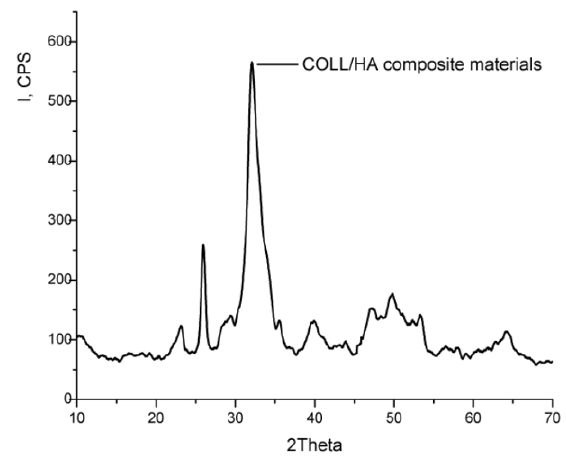
Figure 2. XRD pattern of COLL/HA composite material. Table 1. Ceramic properties of some COLL/HA composite materials with different morphology. Ceramic